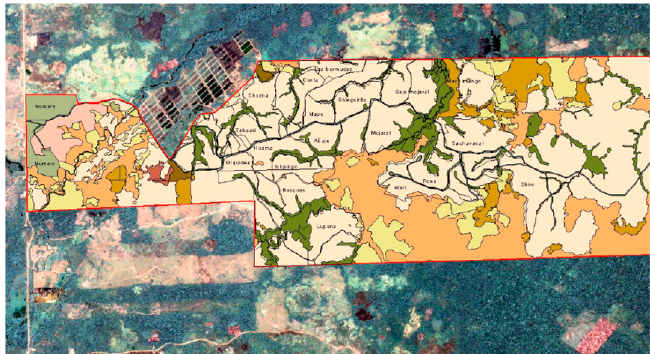
Figure 7. The western side of the Campo Verde Project showing the management units to be reforested.